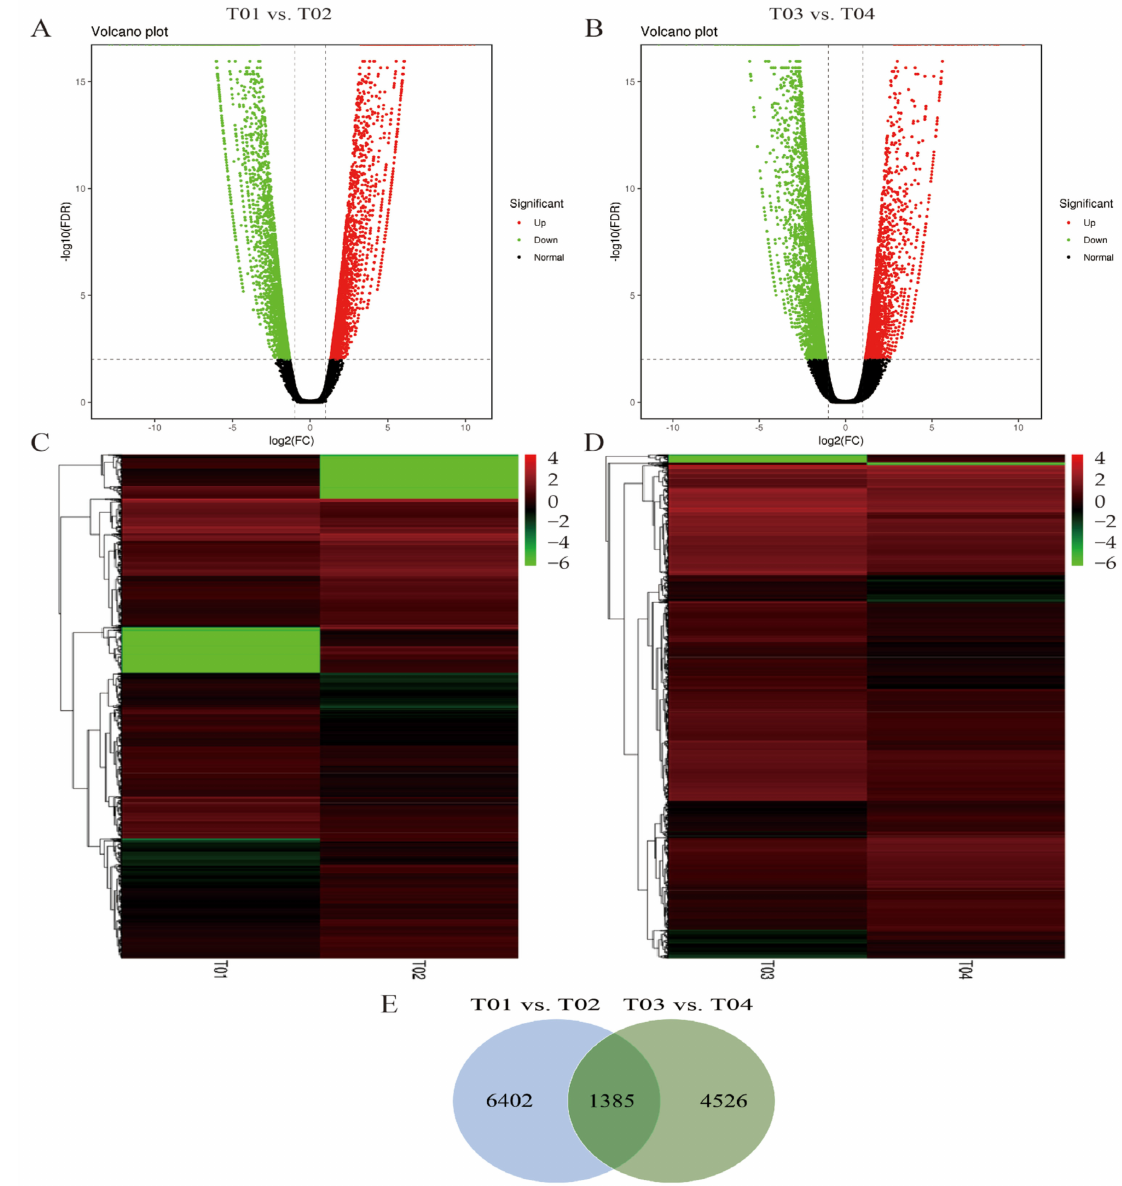
Figure 1. Differentially expressed genes (DEGs) between YT93-159 (T01) and ROC22 (T02), and between the SBS-susceptible bulk (T03) and SBS-resistant bulk (T04). Volcano plot analysis of DEGs for the pairwise comparisons T01 vs. T02 ( A ) and T03 vs. T04 ( B ). Hierarchical cluster analysis of DEGs for the pairwise comparisons T01 vs. T02 ( C ) and T03 vs. T04 ( D ). Wayne map analysis of DEGs between the pairwise comparisons T01 vs. T02 and T03 vs. T04 ( E